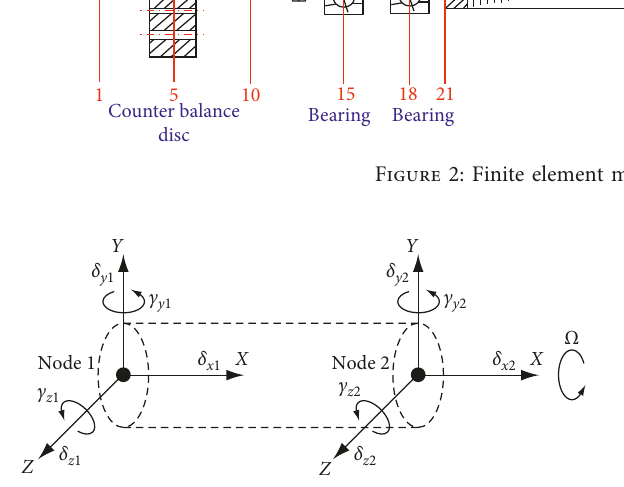
Figure 3: Timoshenko beam